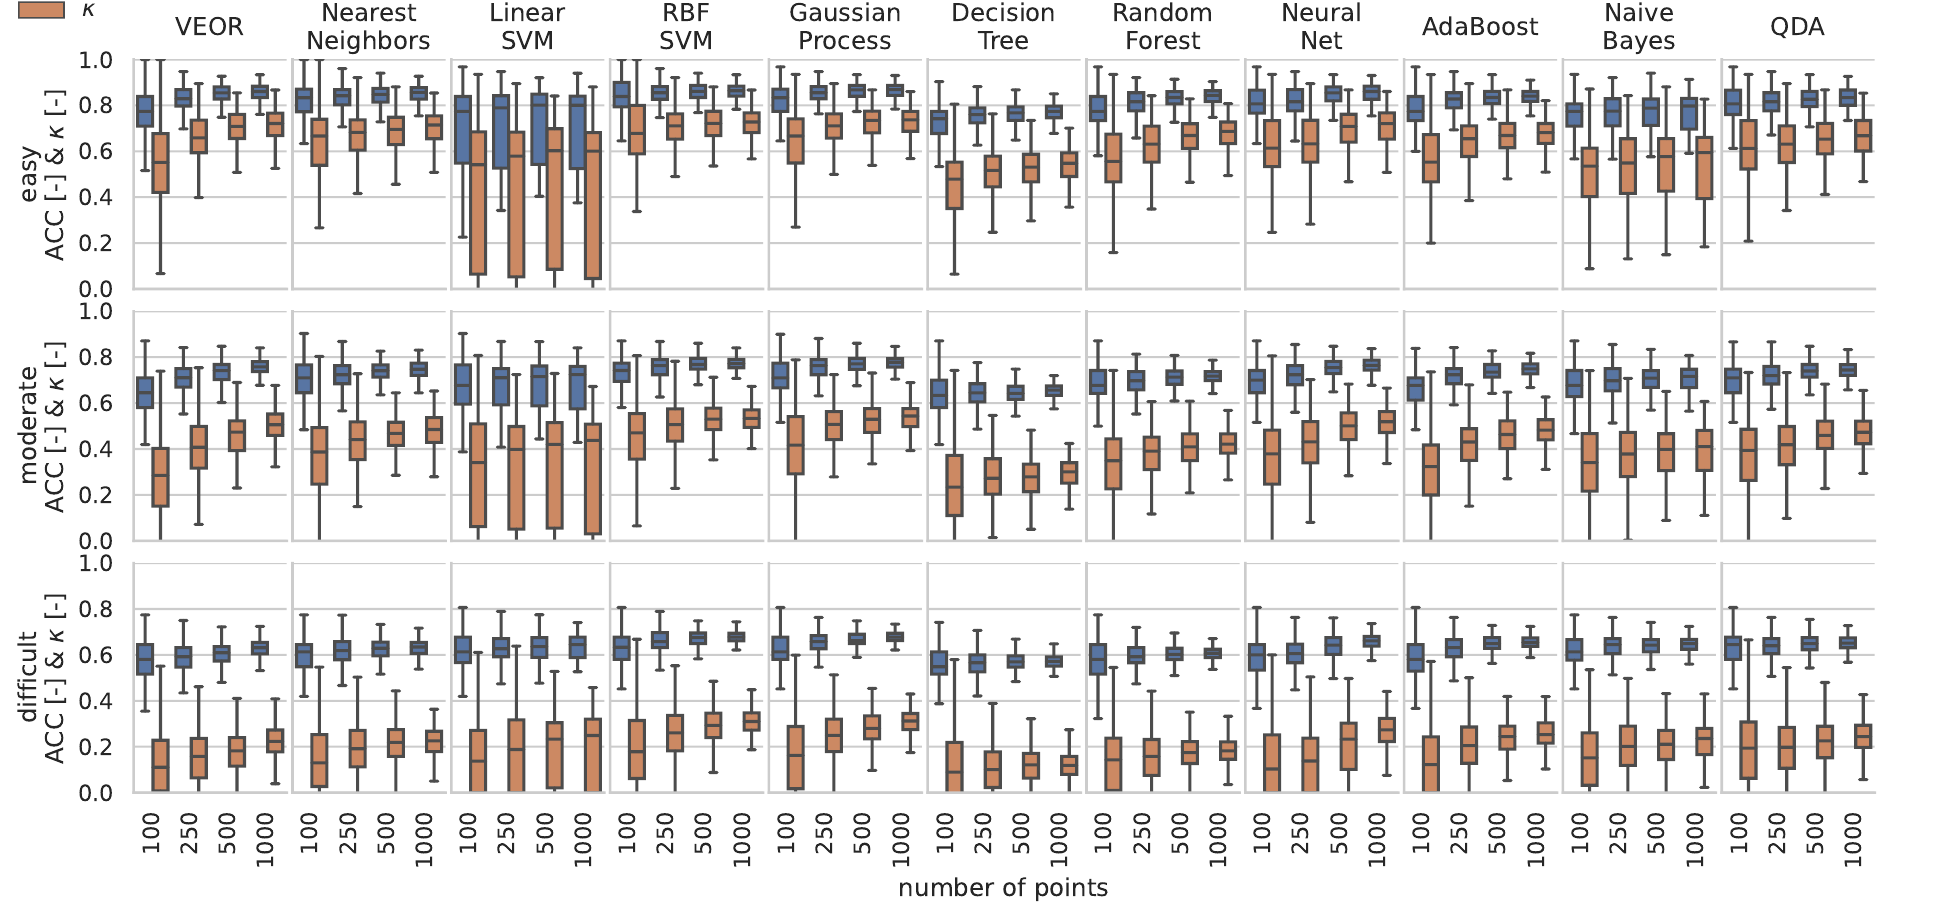
Figure 5. Summary of experiments with combined synthetic linear, moons and circles 2D datasets grouped according to classification difficulty. Easy datasets feature 10% of mislabeled samples and a 50%/50% class balance; moderate datasets feature 20% of mislabeled samples and a 40%/60% class imbalance; difficult datasets feature 30% of mislabeled samples and a 30%/70% class imbalance. Each experiment was repeated 30 times with randomly generated